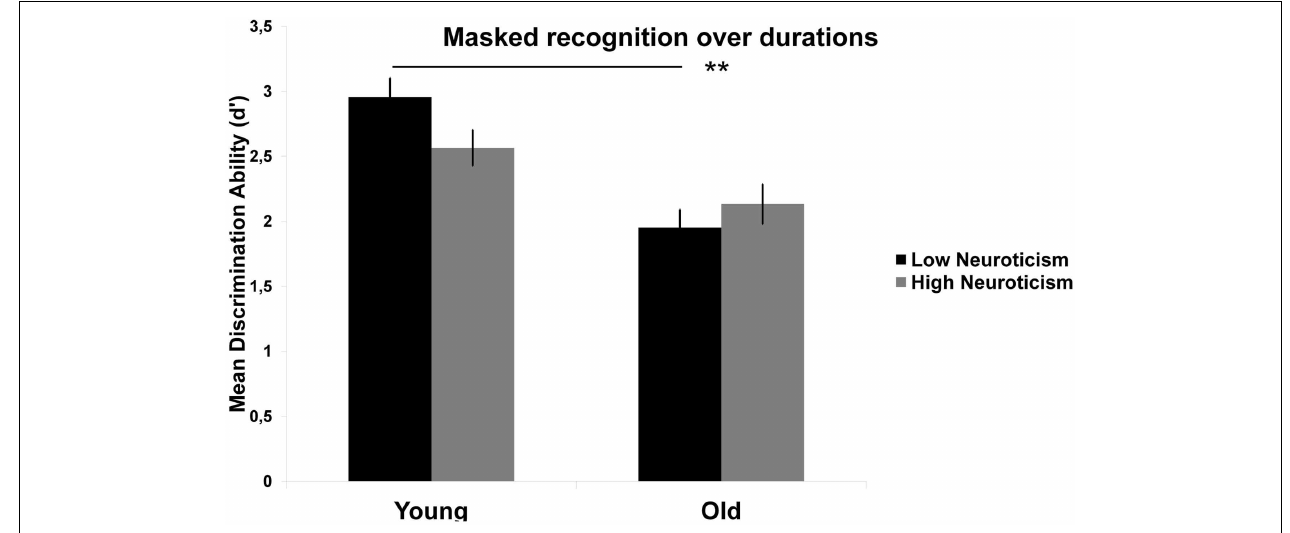
FIGURE 4 | Mean (SE) recognition performance ( d (cid:48) ) in the masked recognition task (across emotions and durations) for age and neuroticism. Note. Results of t -tests are denoted with asterisks. ** p < 0.01, * p <